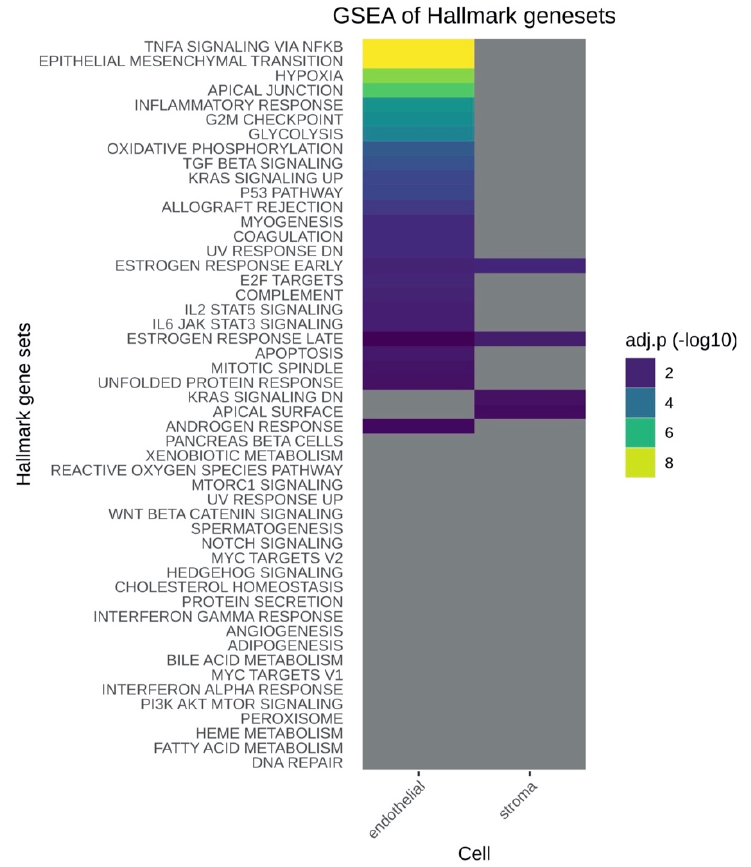
Figure 4. GSEA (Gene Set Enrichment Analysis) extracted from the next generation sequencing data of the stroma and Descemet membrane/endothelium (DmE) complex of donor corneas after 25 days of differential culture conditions in either 2% HPL or 2% FBS-containing medium (2%HPL vs 2%FBS). Grey clusters indicate no significant differences between 2%HPL and 2%FBS. Significant differential gene regulation is indicated by coloring the clusters according to adjusted p -values. Please also see Supplementary Data S4 for examples of the associated DGEA (Differential Gene Expression Analysis).